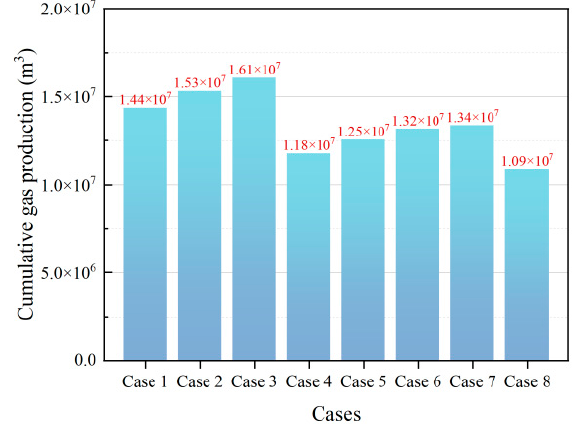
Figure 10. Cumulative gas production of different cases.